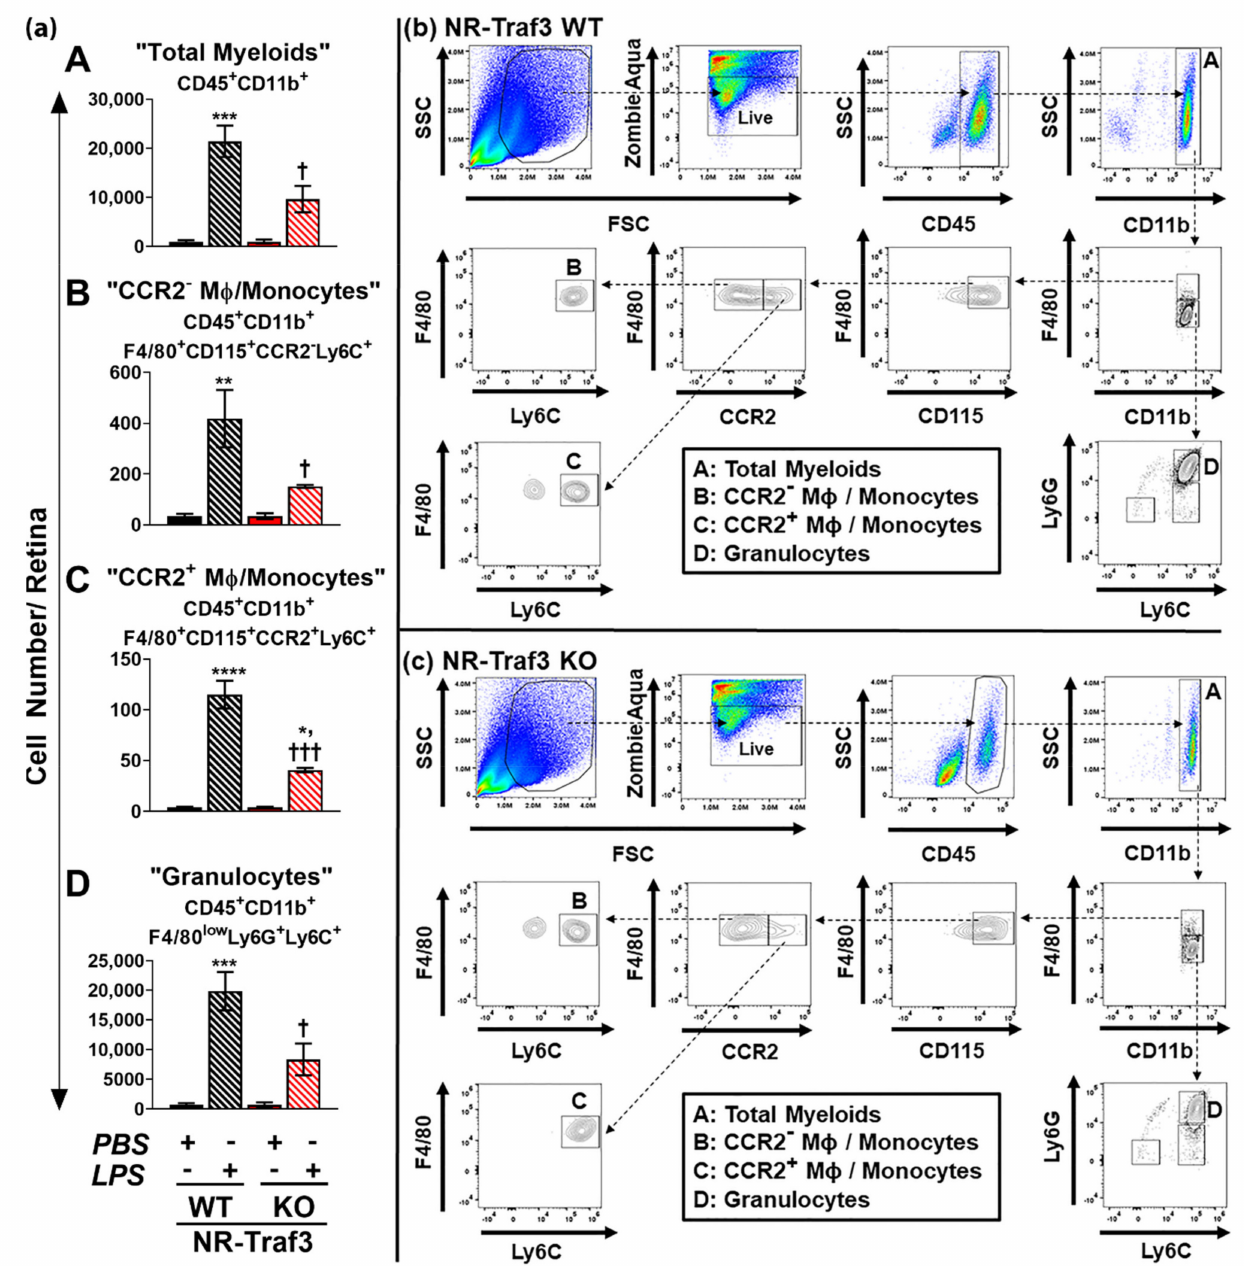
Figure 6. NR- Traf3 promotes LPS-induced retinal immune cell infiltration (7-color). Flow cytometry data represent- ing ( a ) grouped histogram quantification and ( b ) representative NR- Traf3 WT and ( c ) KO dot plots for 7-color flow cytometry detection of immune cells from whole retinal single cell suspensions following 24 h intravitreal LPS ad- ministration. Data for ( a ) are the mean ± SEM and were analyzed via two-way ANOVA with Tukey’s multiple com- parisons post hoc test (LPS effect: **** p < 0.0001, *** p < 0.001, ** p < 0.01, * p < 0.05; Genotype effect: ††† p < 0.001, † p < 0.05; n = 3). Immune cell populations of interest are designated A–D: A, total myeloids (CD45 + CD11b + ); B, CCR2 − macrophages (M Φ )/monocytes (CD45 + CD11b + F4/80 + CD115 + CCR2 + Ly6C + ); C, CCR2 + macrophages (M Φ )/monocytes (CD45 + CD11b + F4/80 + CD115 + CCR2 − Ly6C + ); D, granulocytes (CD45 + CD11b + F4/80 low Ly6G + Ly6C +